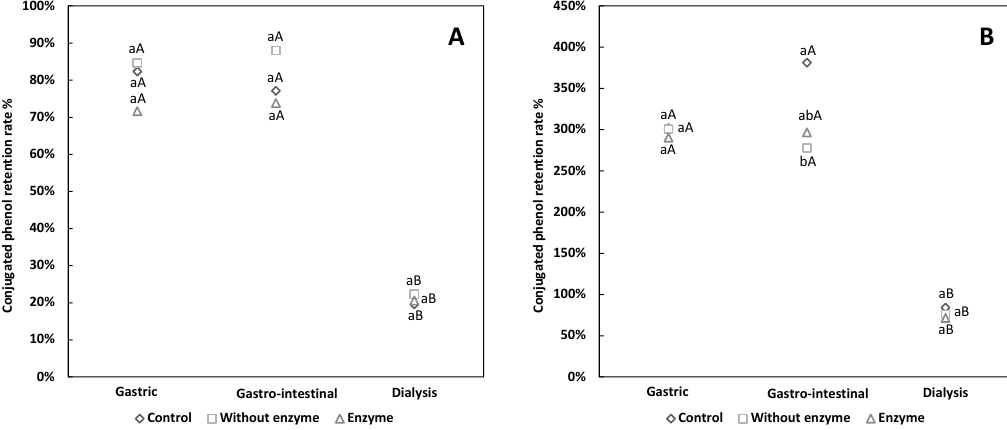
Figure 3. The conjugated phenol retention rate of walnut pigment from brown shell ( A ) and green husk ( B ) subjected to simulated in vitro gastric and intestinal digestion and dialysis (potential uptake). The data presented in this figure consist of average quantities ± SD of three independent samples. Di ff erent letters in the bars within each group represent statistically significant di ff erences ( p < 0.05). “a–c” indicates significant di ff erence in longitudinal, and “A–C” represents significant di ff erence in lateral. maybe converted or degraded into other chemical compounds.